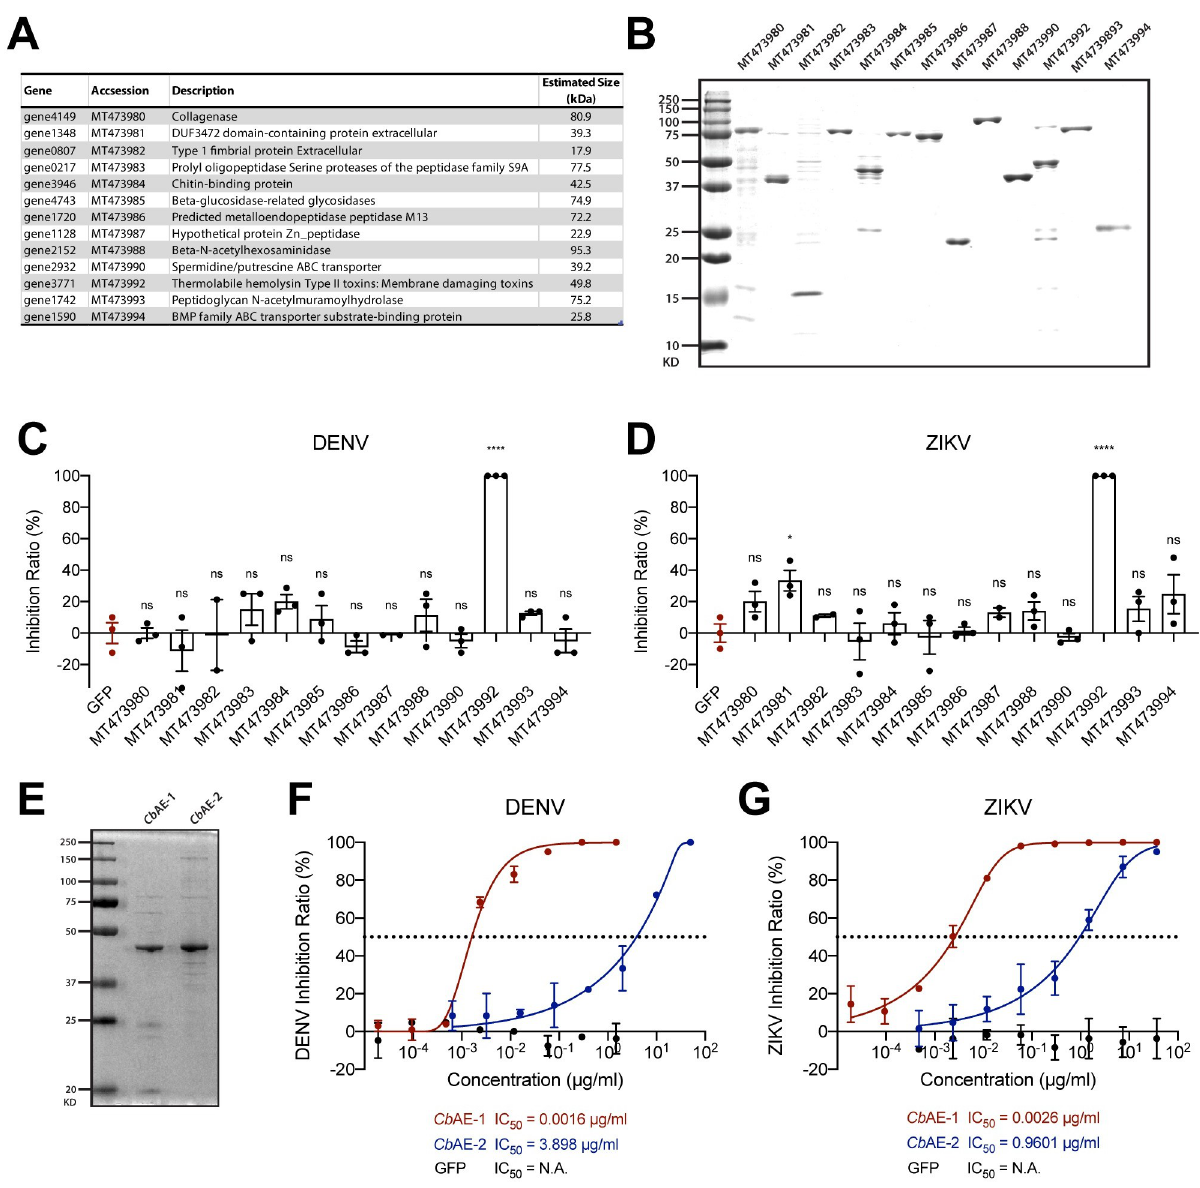
Fig 3. Identification of Csp_BJ -secreted antiviral effector(s) against DENV or ZIKV. (A) The protein description was obtained from the UniProt and NCBI databases. (B) The identified Csp_BJ proteins were expressed and purified from E . coli cells. (C, D) A total of 1 μ g of purified recombinant protein was mixed with 50 PFU of DENV (C) or ZIKV (D) in VP-SFM medium and incubated for 1 hr before infecting Vero cell monolayers. (E-G) Csp_BJ inhibited DENV and ZIKV infections via its secreted proteins Cb AE-1 and Cb AE-2. (E) The identified Csp_BJ secreted proteins Cb AE-1 and Cb AE-2 were expressed and purified from E . coli cells. (F, G) Inhibition curves of Cb AE-1 and Cb AE-2 against DENV (F) and ZIKV (G). Serial concentrations of Cb AE-1 or Cb AE-2 were mixed with 50 PFU of DENV or ZIKV in VP-SFM medium to perform standard plaque reduction neutralization tests (PRNTs). (C, D) Significance was determined using unpaired t tests. Data are presented as the mean ± SEM. P values were adjusted using Dunnett’s test to account for multiple comparisons. The P value represents a comparison between the control group and the other groups. � P < 0.05, ���� P < 0.0001, ns, not significant. Experiments consisted of at least three biological replicates with similar results. the half-inhibitory concentration (IC ) of Cb AE-1-truncated was 20–80 times higher than 50 that of Cb AE-1, indicating impaired virucidal activity of Cb AE-1-truncated (S3 Fig). Since the Cb AEs showed direct enzymatic action on the viral lipid bilayer, we assessed their virucidal activity against other mosquito-borne viruses. The culture supernatant of JEV, YFV